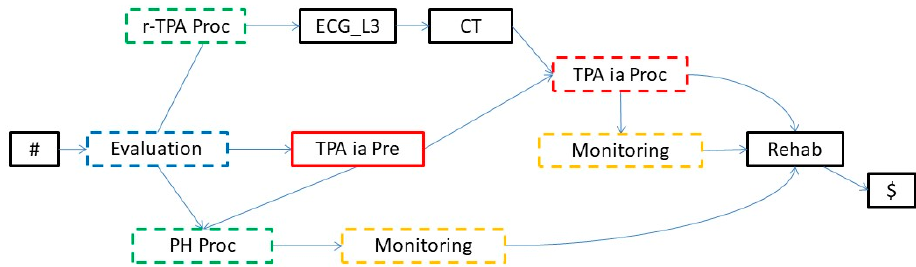
Figure 10. Process model abstracted at level 2 through the solution in Figure 11b.